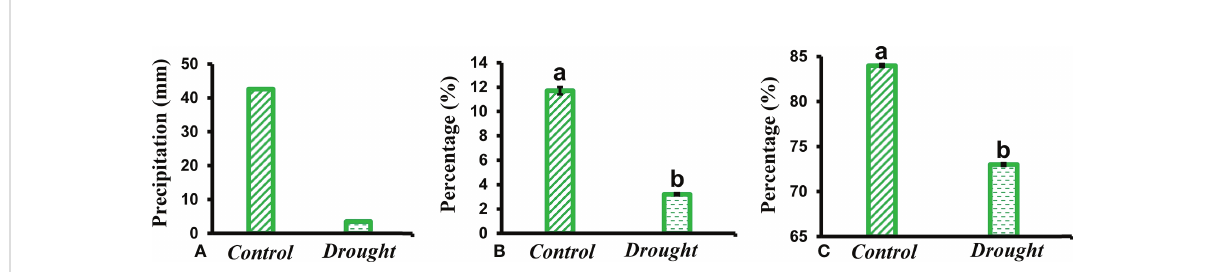
FIGURE 1 Meteorological data. (A) total rainfall received in control and drought plots throughout the study period (B) soil moisture content (SMC) measured in soil obtained from control and drought treated pots kept within the Plexiglas roof (C) relative water content (RWC) measured in leaves of control and drought stressed plants 32 DAT. Means denoted with different letters indicate signi fi cance at